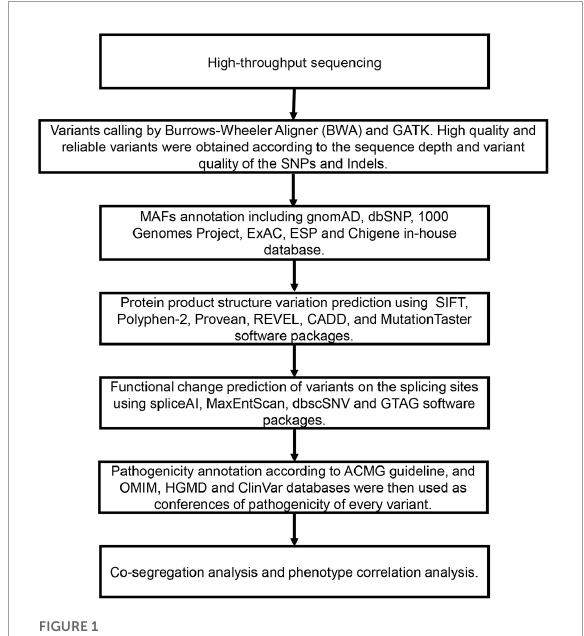
FIGURE1 The filtering and analysis strategy and analysis process of variations screening from Trio-WES